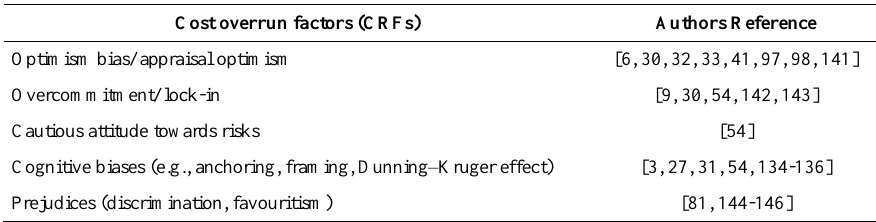
Table 4. Critical Risk Group (Root Cause) -